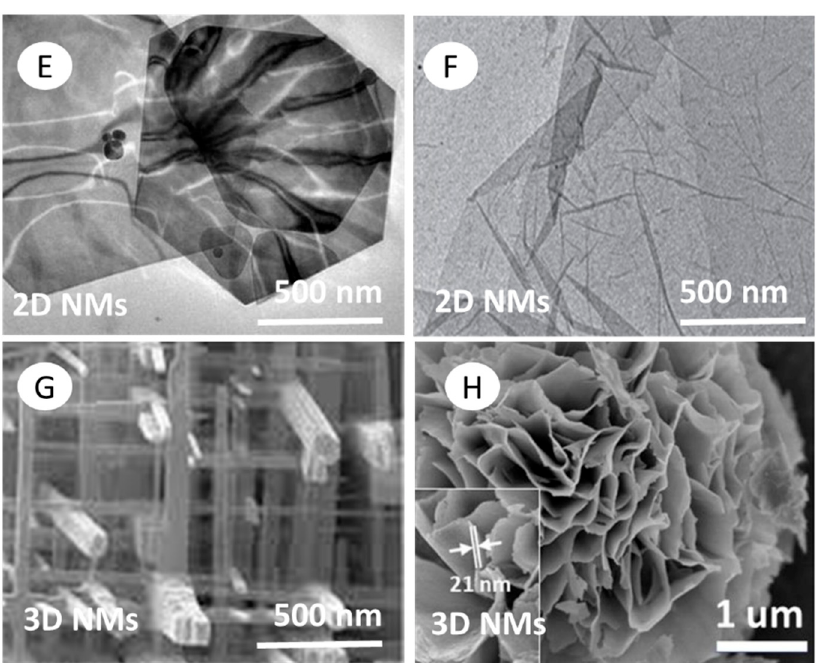
Figure 8. Different morphologies observed in nanomaterials with different dimensionality: ( A ) 0D nonporous monodispersed Au nanoparticles (0D) [109], © Elsevier, 2013; ( B ) 0D mesoporous silica nanoparticles (0D) [110], © MDPI, 2019; ( C ) 1D silver nanorods [111], © American Chemical Society, 2011; ( D ) 1D carbon nanotubes array [112], © IntechOpen, 2011; ( E ) 2D CuSe nanosheets [113], © Nature, 2014; ( F ) 2D graphene nanosheets [114], © Nature, 2012; ( G ) 3D WO 3 nanowire network [115], © Beilstein Institute for the Advancement of Chemical Sciences (Germany), 2018; and ( H ) 3D flake-flower NiO nanostructures [116], © Frontiers, 2020.